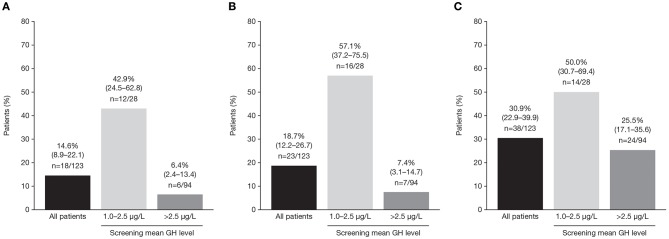
Percentage (95% CI) of patients with (A) mGH <1.0 μg/L and IGF-I <1.0 × ULN, (B) mGH <1.0 μg/L, and (C) IGF-I <1.0 × ULN at week 36, in all patients and by screening mean GH level.